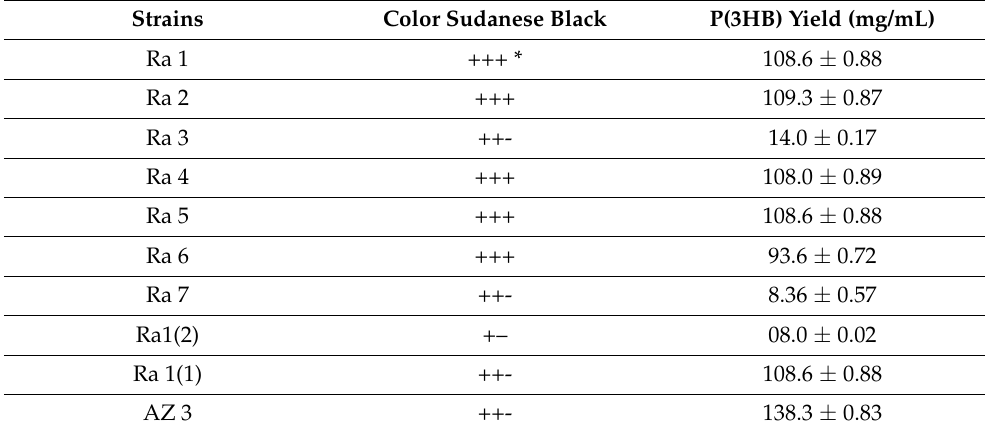
Table 2. Production of P(3HB) by some soil strains in a mineral environment. Strains Color Sudanese Black P(3HB) Yield (mg/mL) Ra 1 +++ * 108.6 ± 0.88 Ra 2 +++ 109.3 ± 0.87 ++-